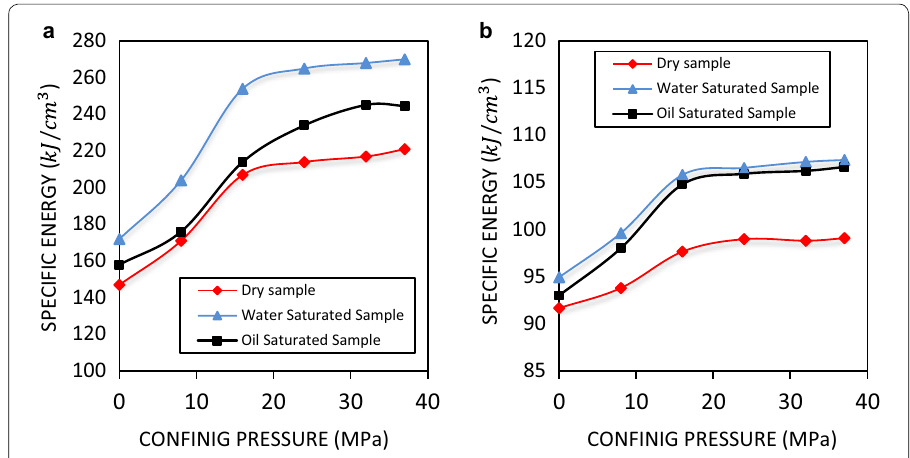
Fig. 4 Specific energy-graph at different lateral pressures for samples of granite ( a ) and limestone ( b ) [2]